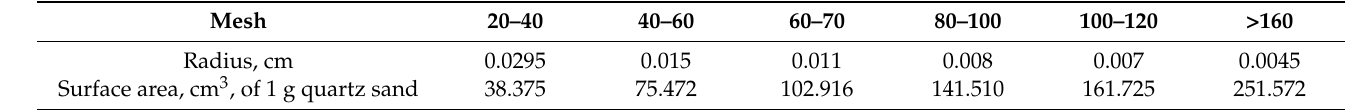
Table 2. Surface area, cm 3 , of 1 g quartz sand with varying mesh sizes.